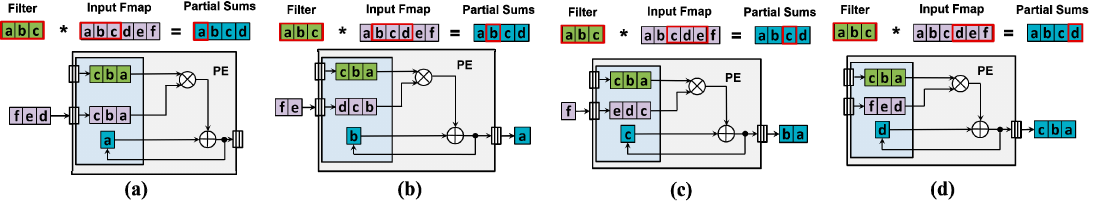
Figure 8. The structure of the gates block.